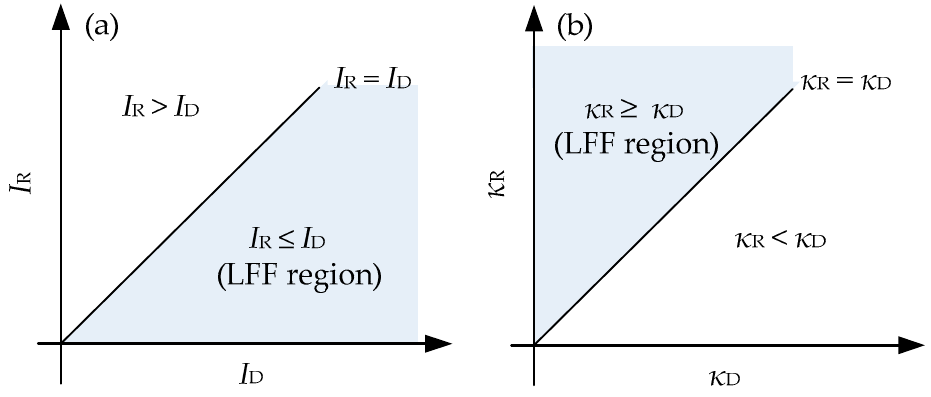
Figure 6. Parameter relationships that can make the response laser generate the LFF dynamic. ( a ) The relationship of I R and I D and ( b ) the relationship between κ R and κ D .